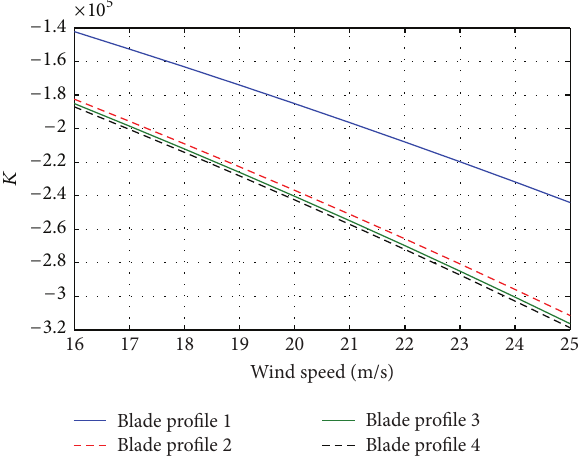
Figure 8: 𝐾 parameter obtained by using different blade profiles.